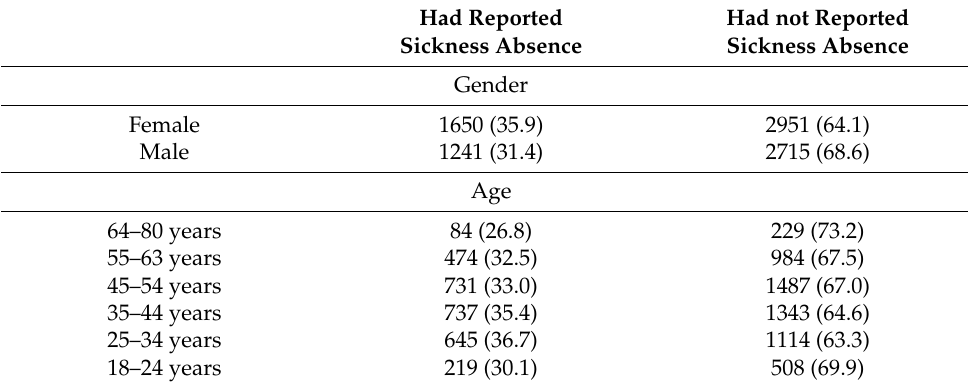
Table A2. Prevalence of self-reported medically certified sickness absence by socio-demographic factors, n